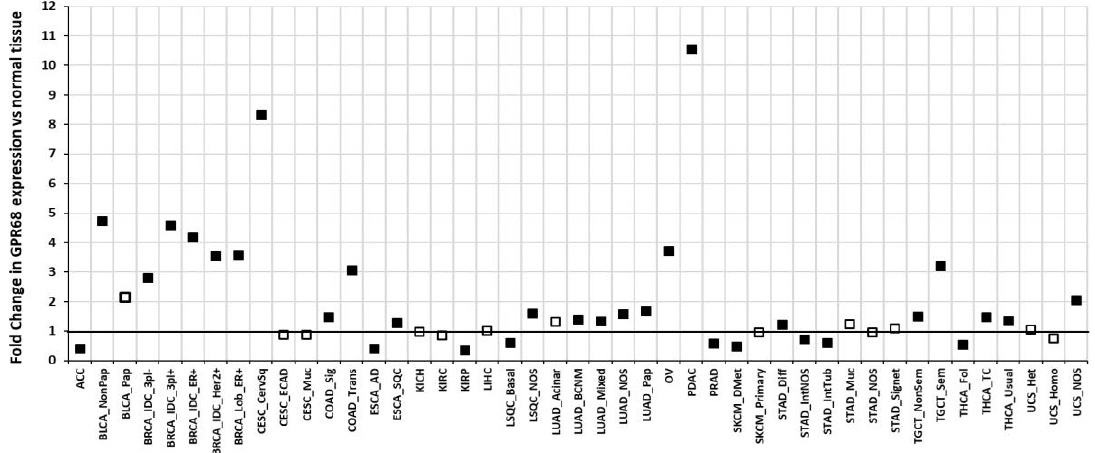
Figure 4. Differential expression of GPR68 in tumors compared to normal tissue. The Cancer Genome Atlas (TCGA) [64] tumors were subdivided into 45 histological subtypes as described previously [24]. Closed squares indicate the fold-changes in GPR68 expression that are statistically significant (false discovery rate (FDR) < 0.05); open squares indicate non-significant fold-changes. Baseline expression in normal tissue is set as 1.